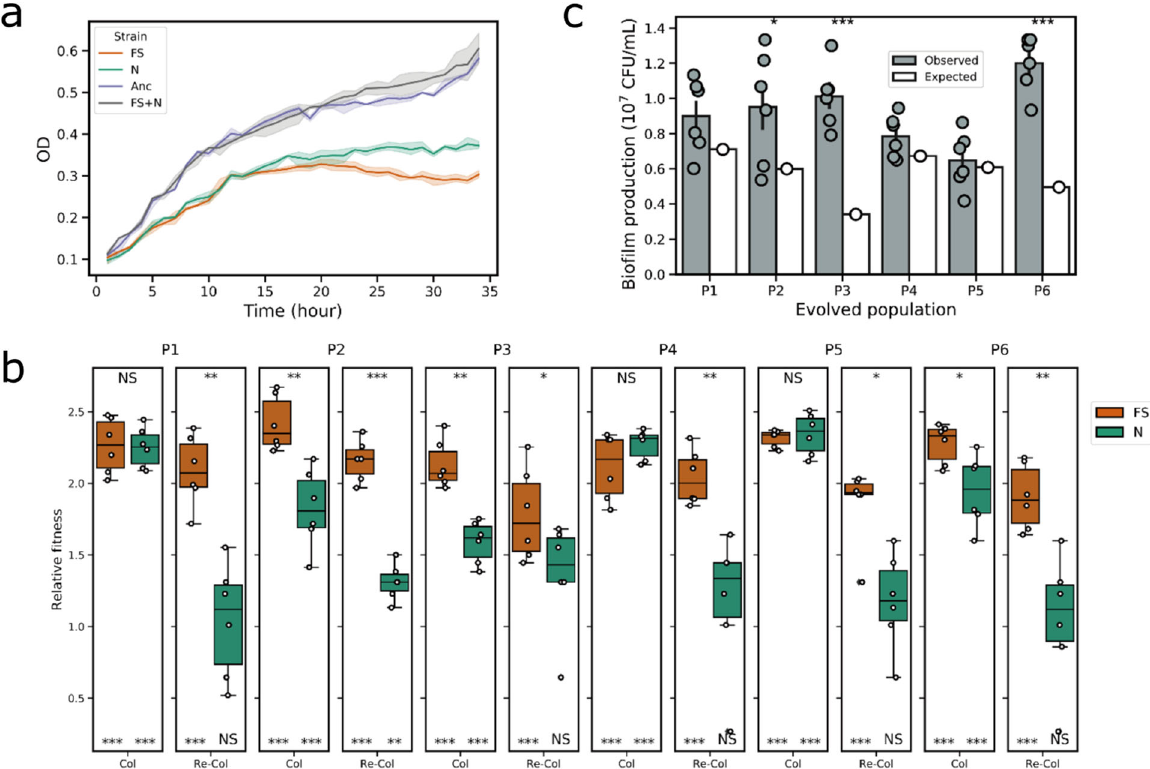
Fig. 3 Morphotype fi tness in planktonic and bio fi lm-forming conditions. a Growth properties of the evolved variants and the ancestor ( n = 6) in EPS medium at 30 °C with continuous shaking (90 rpm). b Relative fi tness of the evolved variants in the bead bio fi lms compared with the ancestor. Columns indicate colonization and re-colonization of evolved populations, respectively (P1-P6). The orange color indicates FS variants and the green color indicates N variants. Boxes indicate Q1 – Q3, lines indicate the median, and bars span from max to min. Asterisks at the top indicate signi fi cant differences between FS and N morph variants. Asterisks at the bottom indicate signi fi cant differences between each group and the ancestor (* p < 0.05, ** p < 0.01, *** p < 0.001; One-way ANOVA followed by Dunnett ’ s multiple comparisons tests). c Observed and expected bio fi lm productions of six evolved populations (P1 – P6). Expected productivities were calculated as the product of the proportion of the evolved variant in each population and their productivities in monocultures. For observed bio fi lm productions, error bars indicate the standard error of the mean of independent biological samples ( n = 6). Asterisks indicate signi fi cant differences between the observed and expected bio fi lm productions (* p < 0.05, *** p < 0.001; two-tailed t -test with Welch ’ s